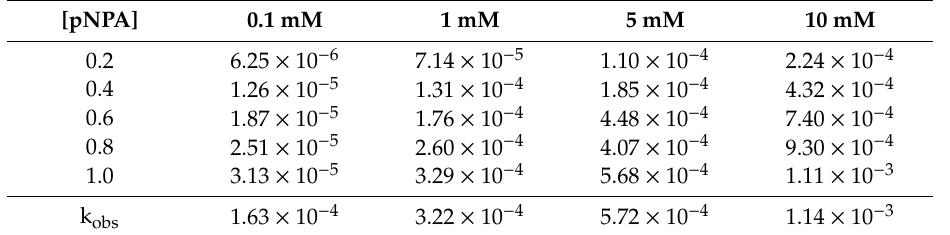
Table 1. Initial velocities (V i expressed in mM / s) at di ff erent concentrations of 4-nitrophenyl acetate